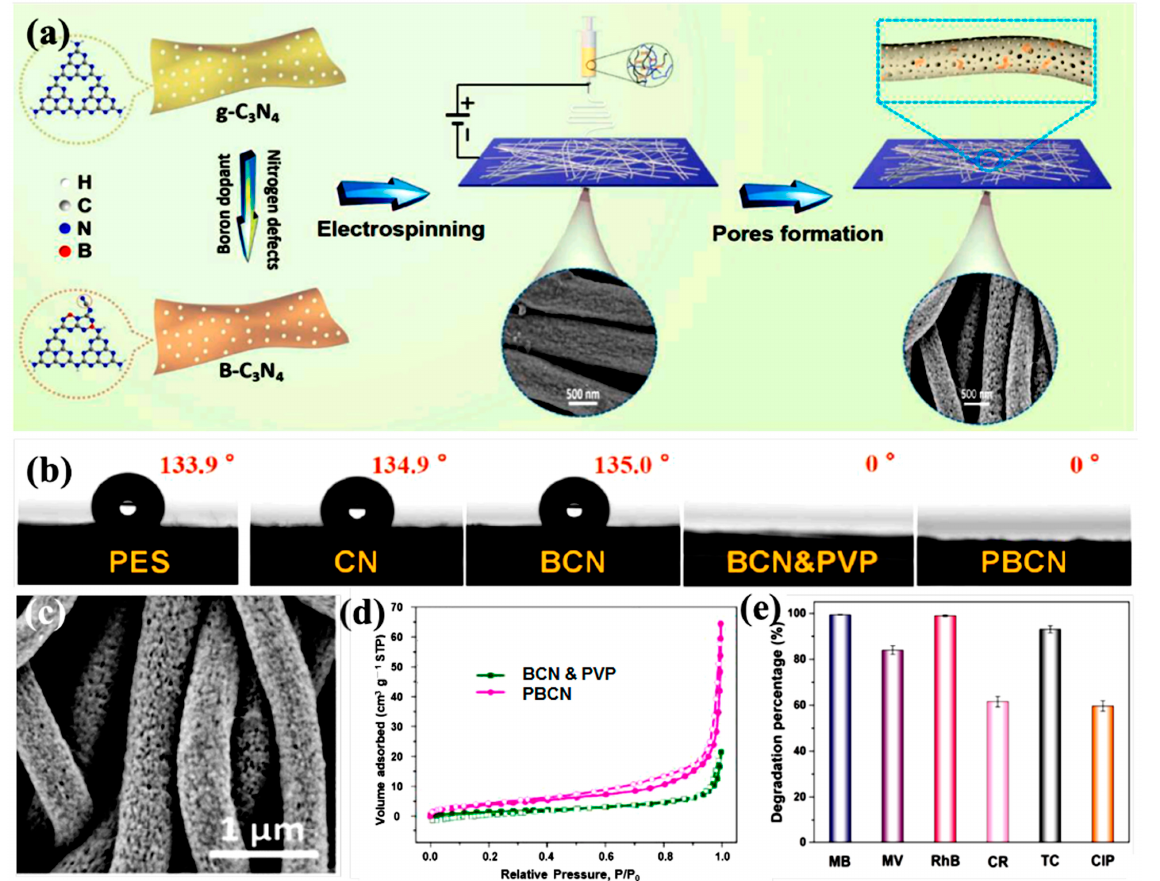
Figure 9. ( a ) Diagram of the fabrication process of PBCN; ( b ) WCAs of prepared nanofibrous membranes; ( c ) SEM image of PBCN nanofibrous membrane; ( d ) N 2 adsorption–desorption isotherms of nanofibrous membranes (pore size distributions are shown in the insert); ( e ) photocatalytic degradation performance for different pollutants. Reprinted with permission from Ref. [150], Copyright 2022, Elsevier.